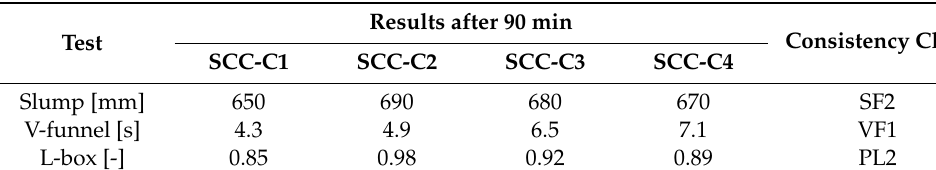
Table 11. SCC concrete mixture test results.